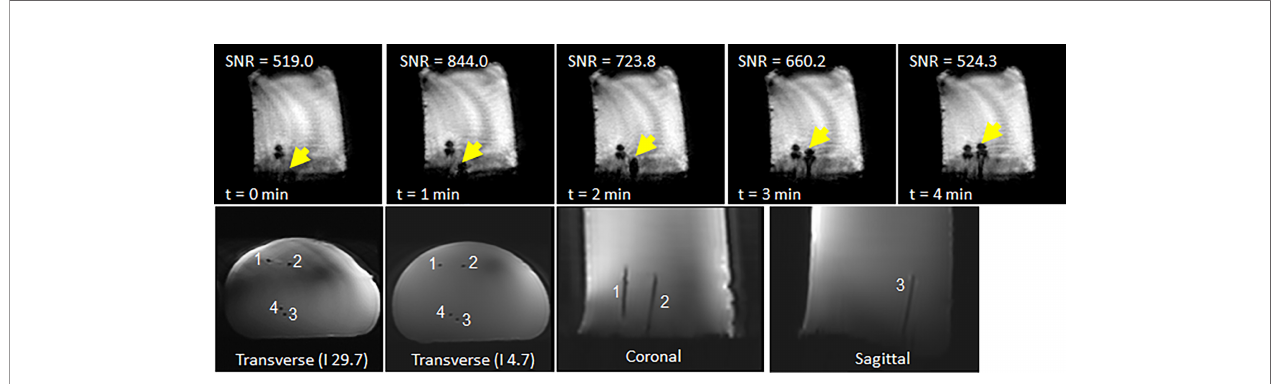
FIGURE 10 | (top row) Representative time-lapse images of showing progression of a second needle inserted to the right of a needle already in place. (bottom row) Final scan of phantom after insertion of four needles: (left) axial scan close to phantom surface; (middle) axial scan close to needle tips; and (right)